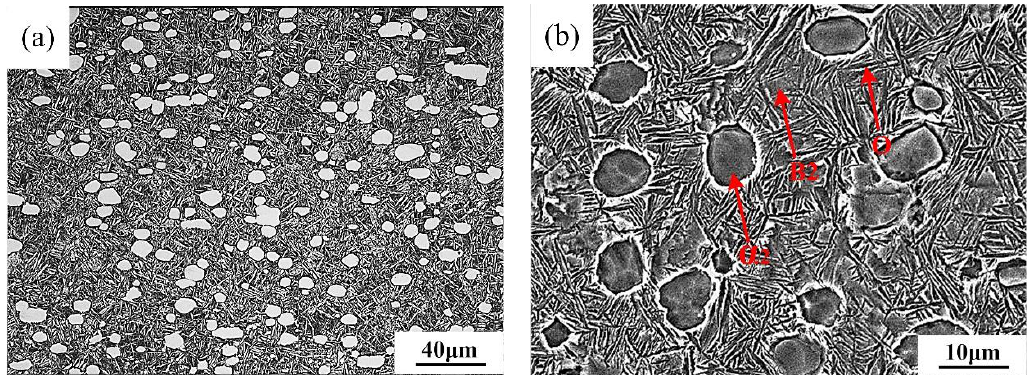
Figure 1. Microstructures of the base metal: ( a ) optics microscopy (OM) image and ( b ) SEM image.